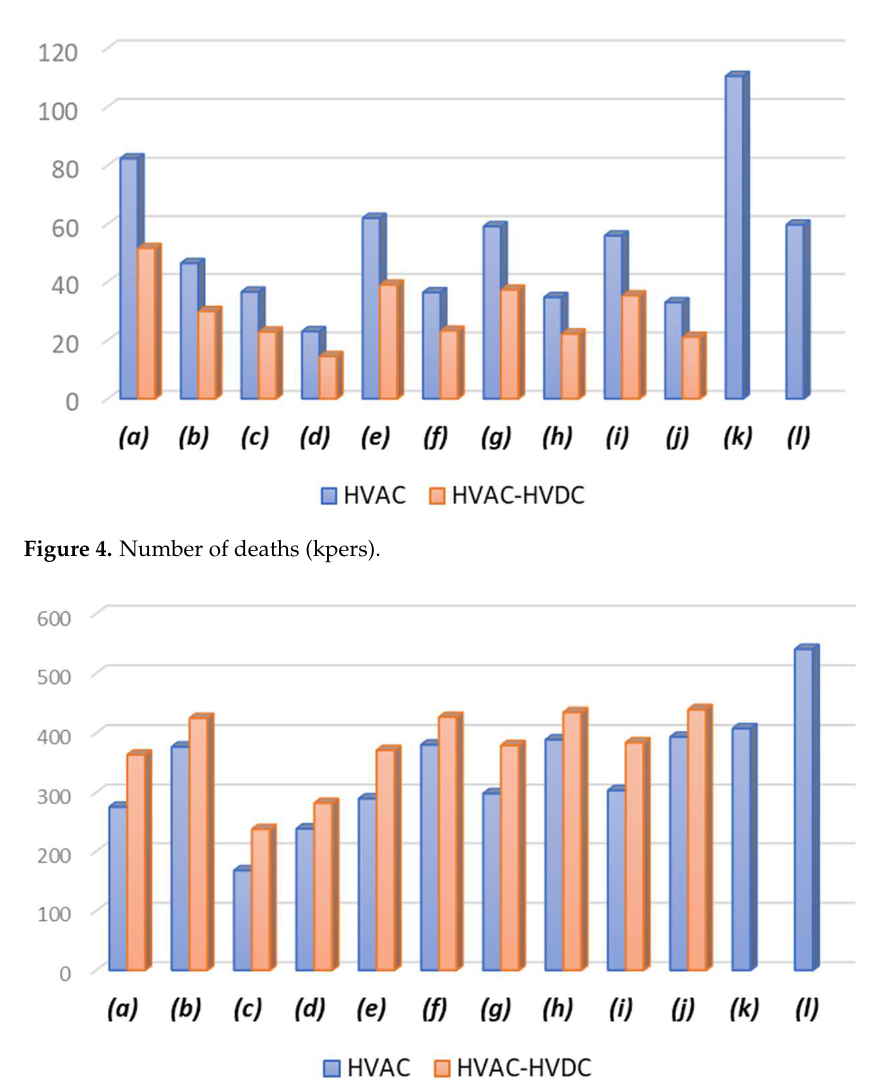
Figure 6. Percentage of RES in TFC (%). Figure 7. Carbon emission over GDP (tCO2/M EUR).